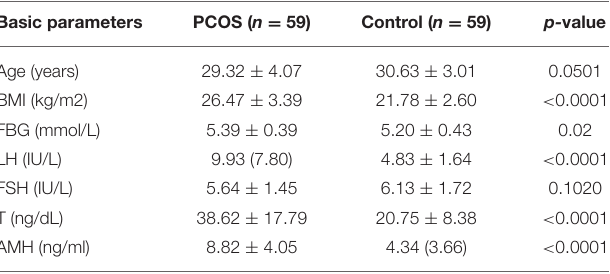
TABLE 2 | Clinical and endocrine parameter of PCOS patients and controls for qRT-PCR. Basic parameters